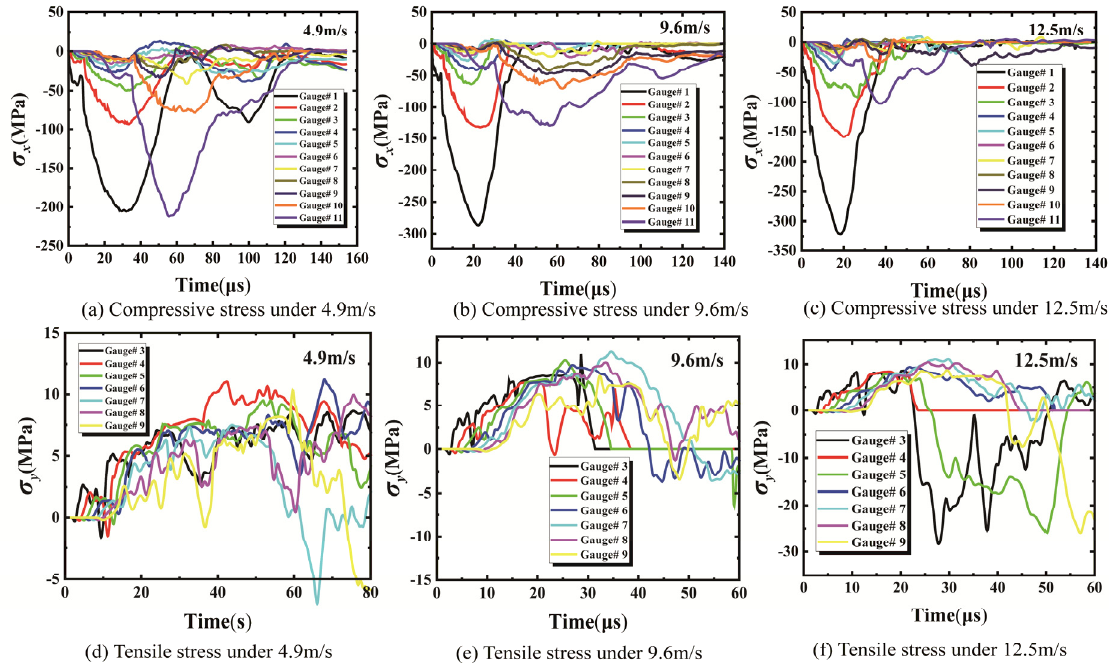
Figure 3. Crack evolution of disc specimens under dynamic load.